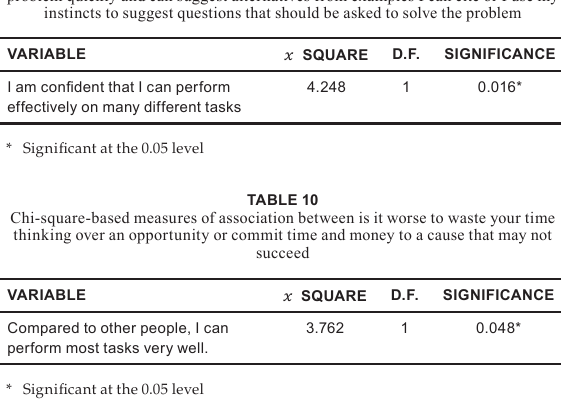
table 9 Chi-square-based measures of association between I recognise key features of the problem quickly and can suggest alternatives from examples I can cite or I use my